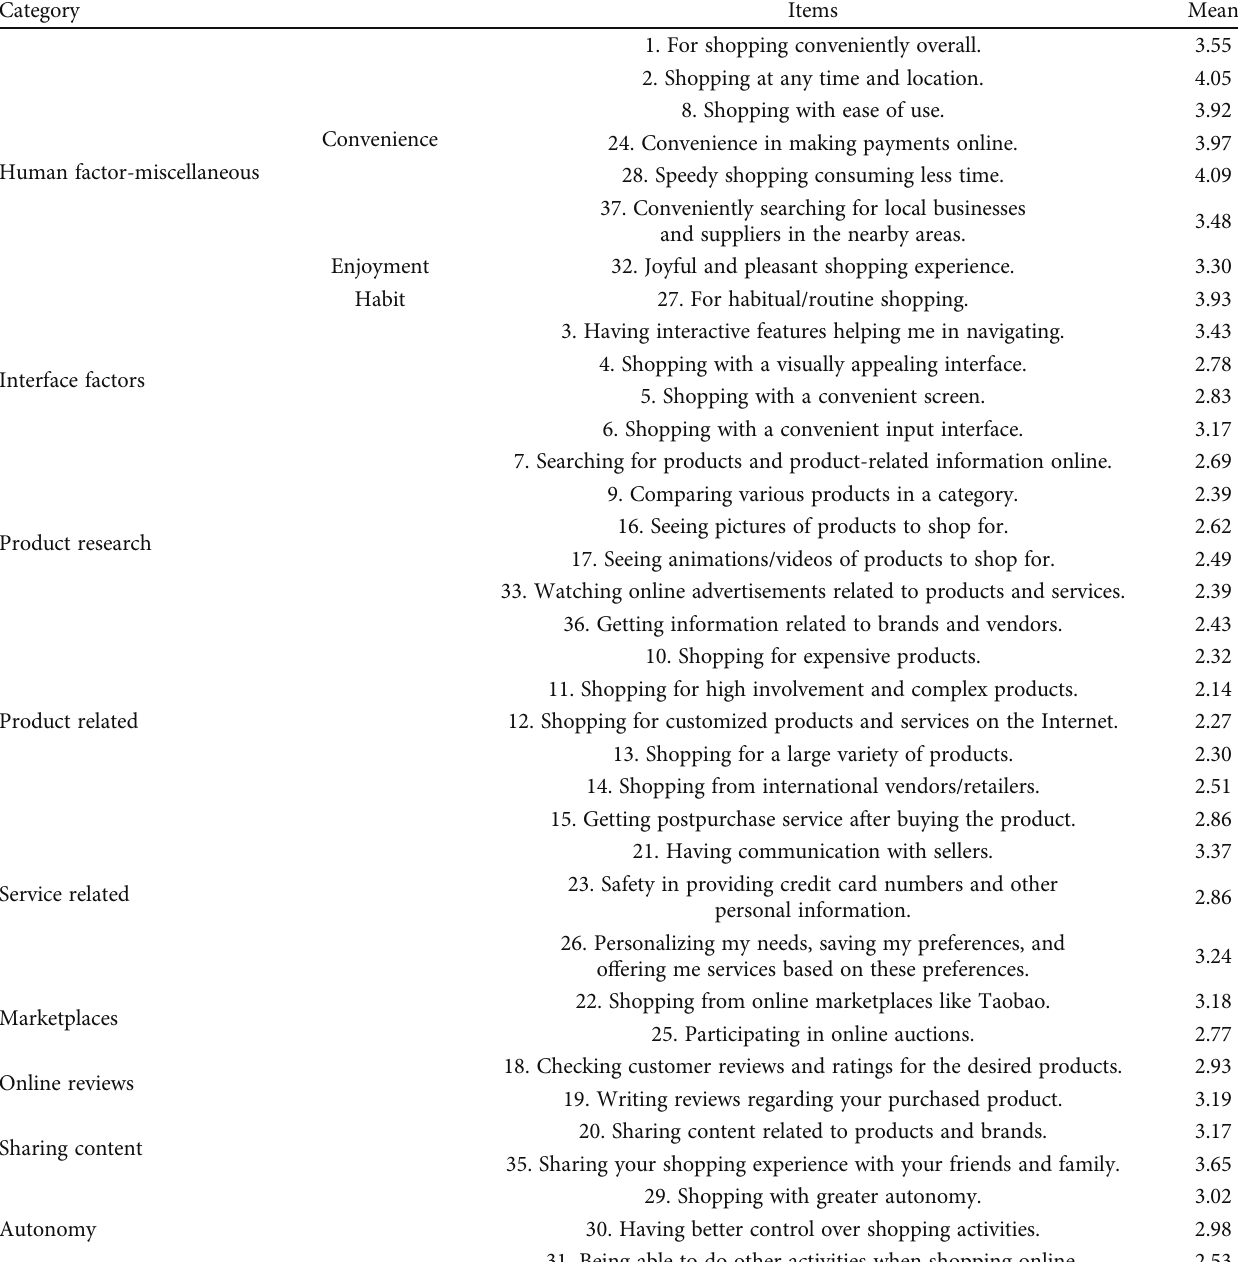
Table 1: Proposed factors and their item